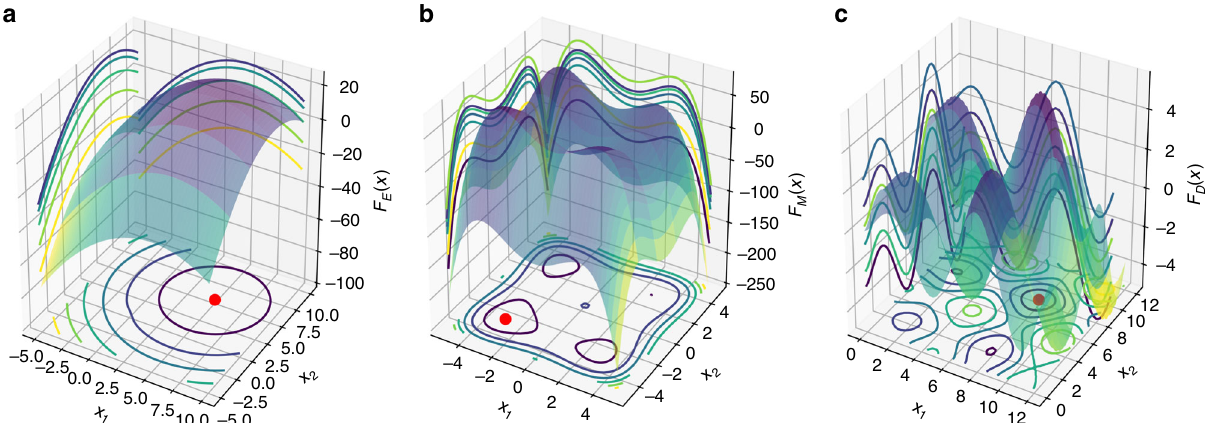
Fig. 4 Synthetic data test functions for ART. These functions present different levels of dif fi culty to being “ learnt ” , and are used to produce synthetic data and test ART ’ s performance (Fig. 5). a F E ð x Þ ¼ (cid:2) 1 d